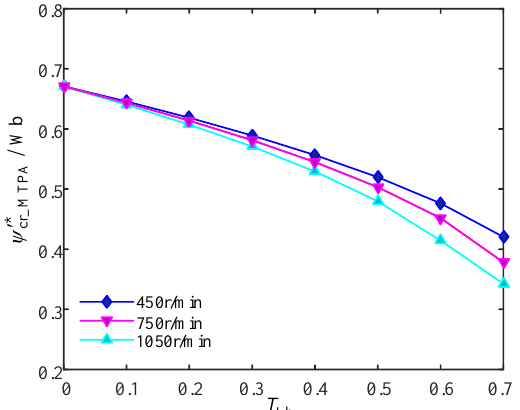
Figure 4. Calculation of   ψ